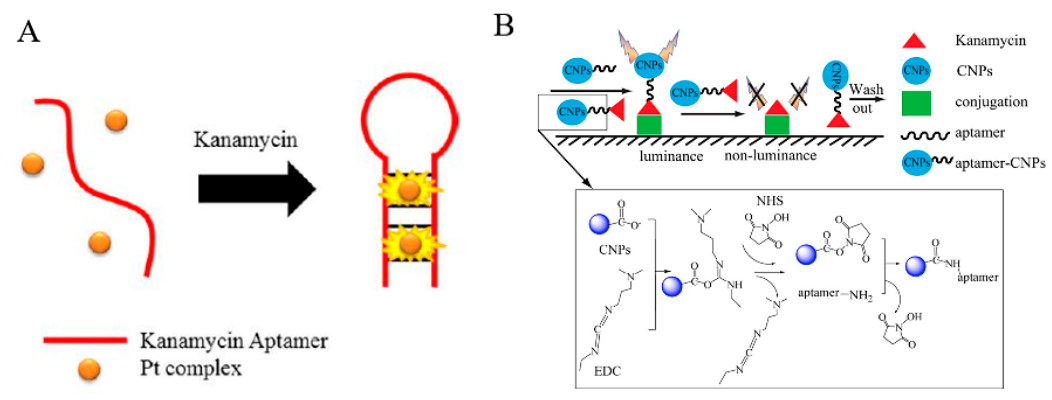
Figure 4. Schematic illustration of a chemiluminescent aptasensor. ( A ) A luminescent probe containing an aptamer and Pt(II) [73]. ( B ) A carbon nanoparticles aptasensor